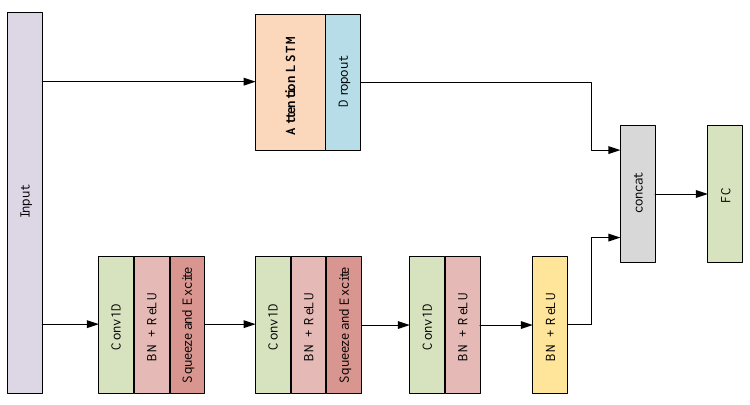
Figure 2. Modified multivariate attention LSTM-FCN (MALSTM-FCN) network structure for time series